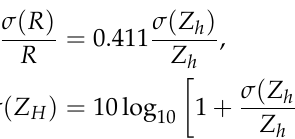
Z − 1.727 , ( c ) R = 17.33 K 0.92 h dr